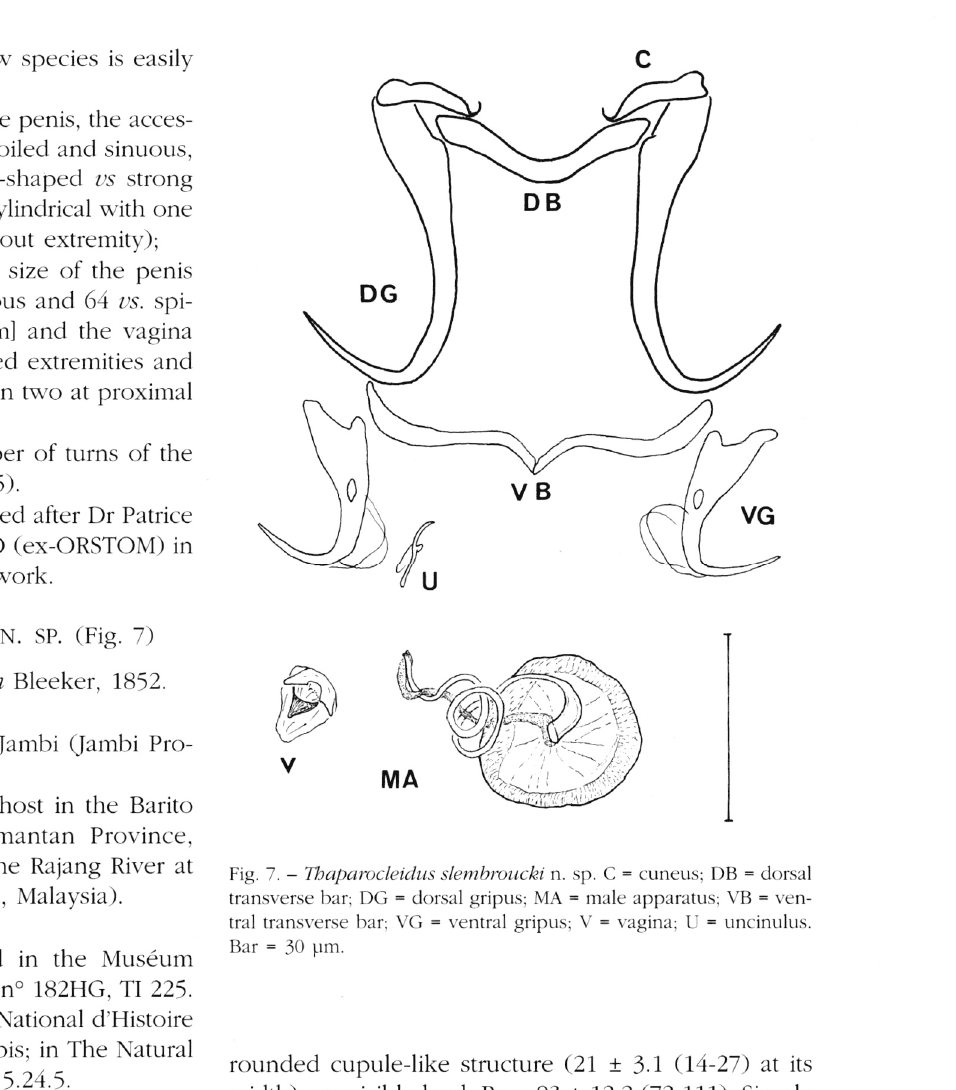
Fig. 7. - Thaparocleidus slembroucki n. sp. C = cuneus; DB = dorsal transverse bar; DG = dorsal gripus; MA = male apparatus; VB = ven­ tral transverse bar; VG = ventral gripus; V = vagina; U = uncinulus. Bar = 30 pm.